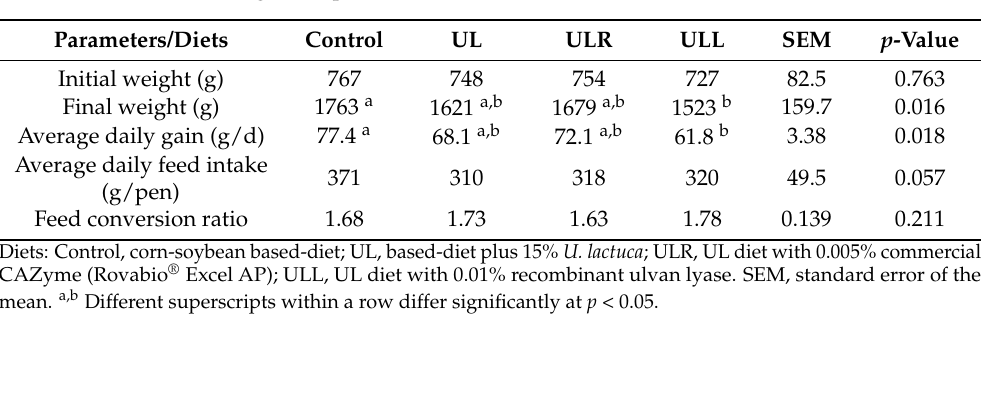
Table 1. Effect of diets on growth performance of broilers ( n =